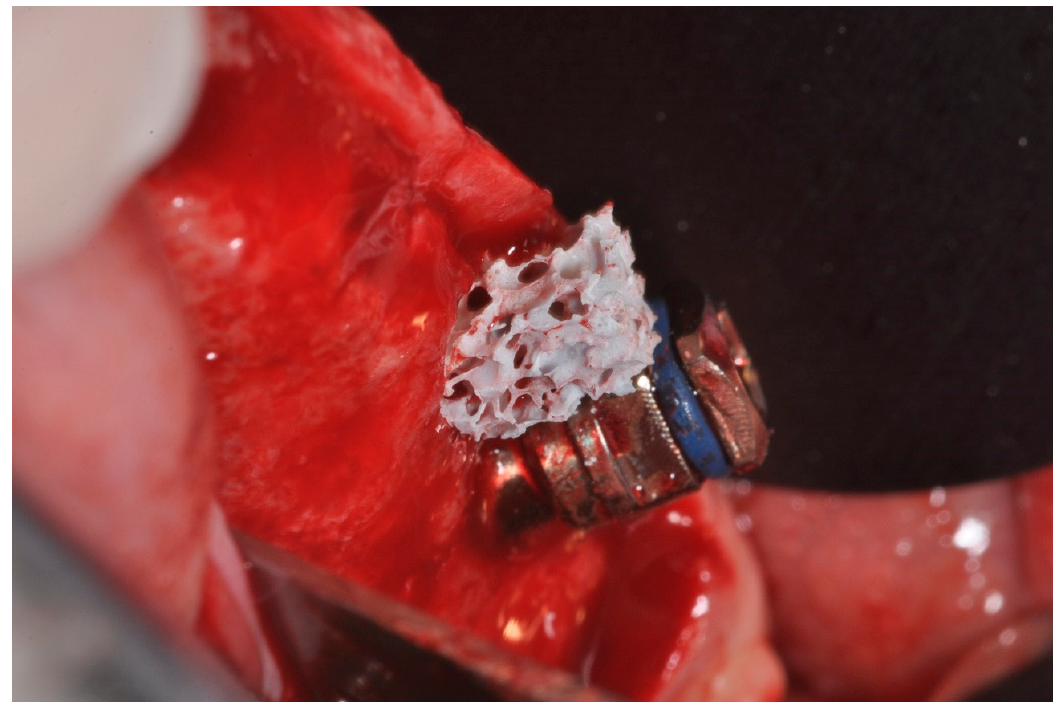
Figure 2. HA scaffold during placement in bone defect.